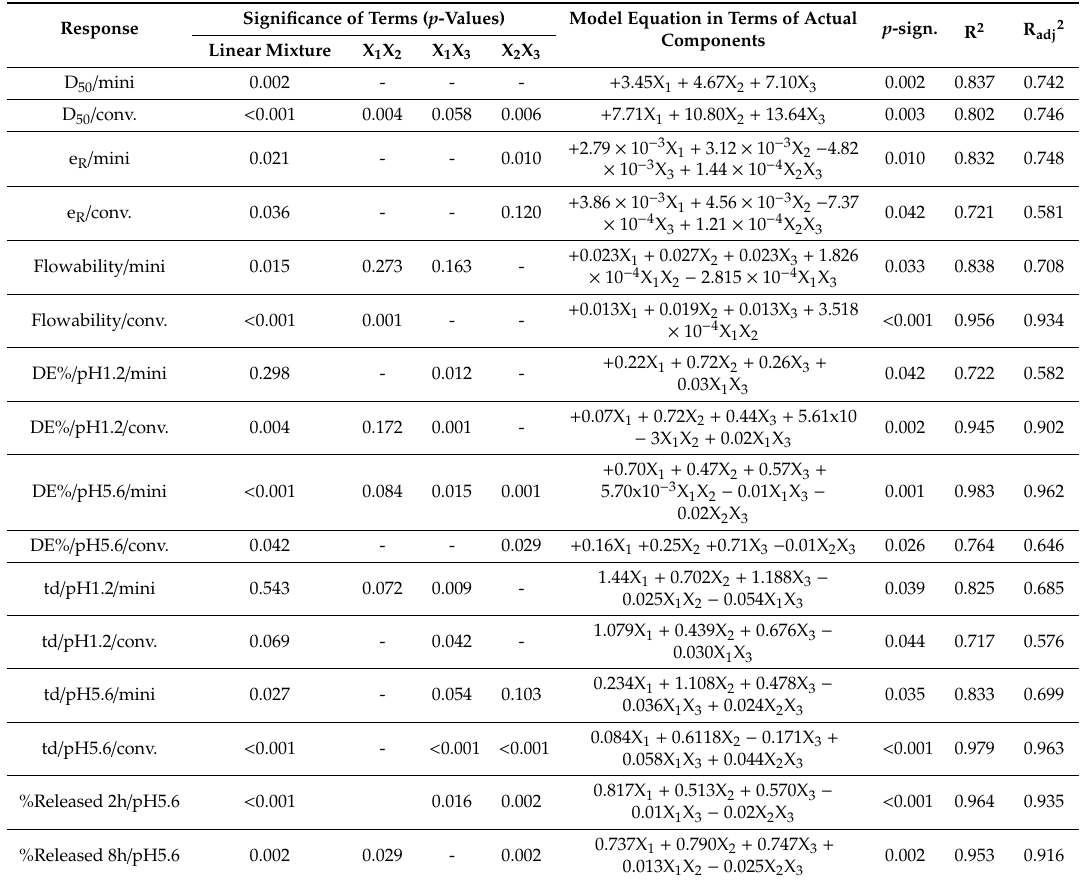
Results of regression analysis of the experimental mixture design based on Sche ff é quadratic